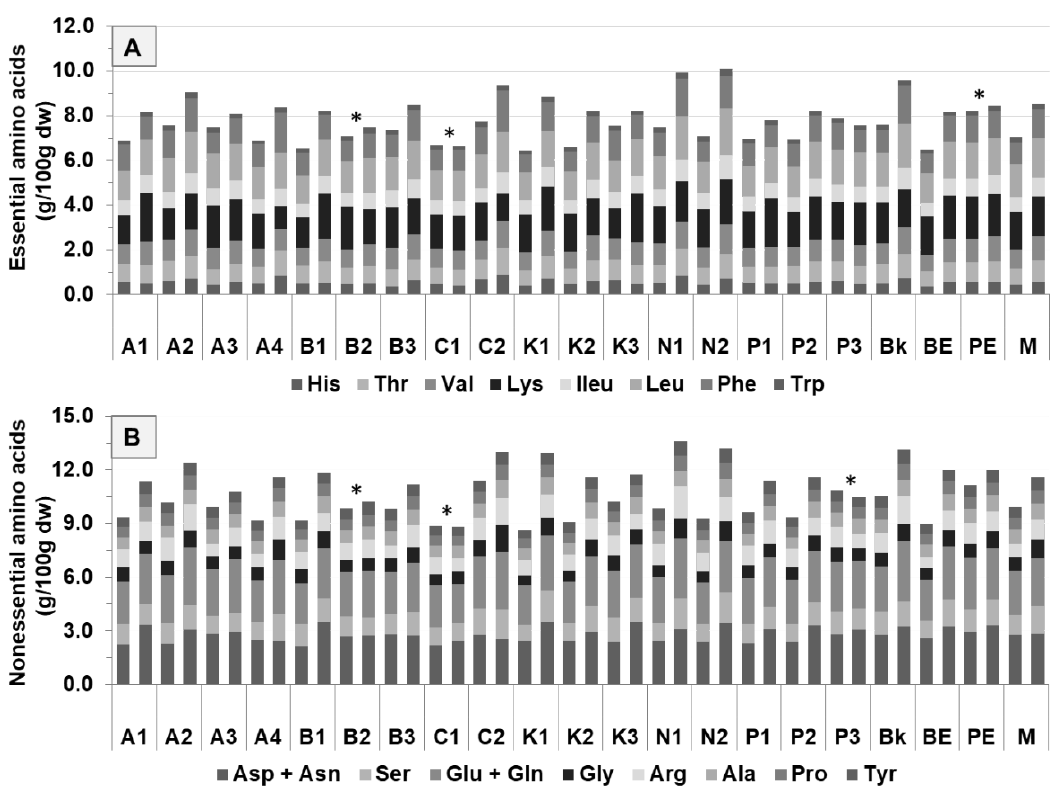
Figure 3. Amino acids of 10 common bean cultivars, grouped according to their morphological characteristics: ( A ) essential amino acids and ( B ) nonessential amino acids for 2013 (for each sample on the left) and 2014 (for each sample on the right) harvest years. Cultivars: Arikara yellow (A1, A2, A3, A4), butter bean (B1, B2, B3), cranberry (C1, C2), red kidney (K1, K2, K3), navy (N1, N2), pinto (P1, P2, P3), black (Bk), brown eyed (BE), pink eyed (PE), and tarrestre (M). *indicates that it does not differ significantly at p < 0.05 between two harvesting years.